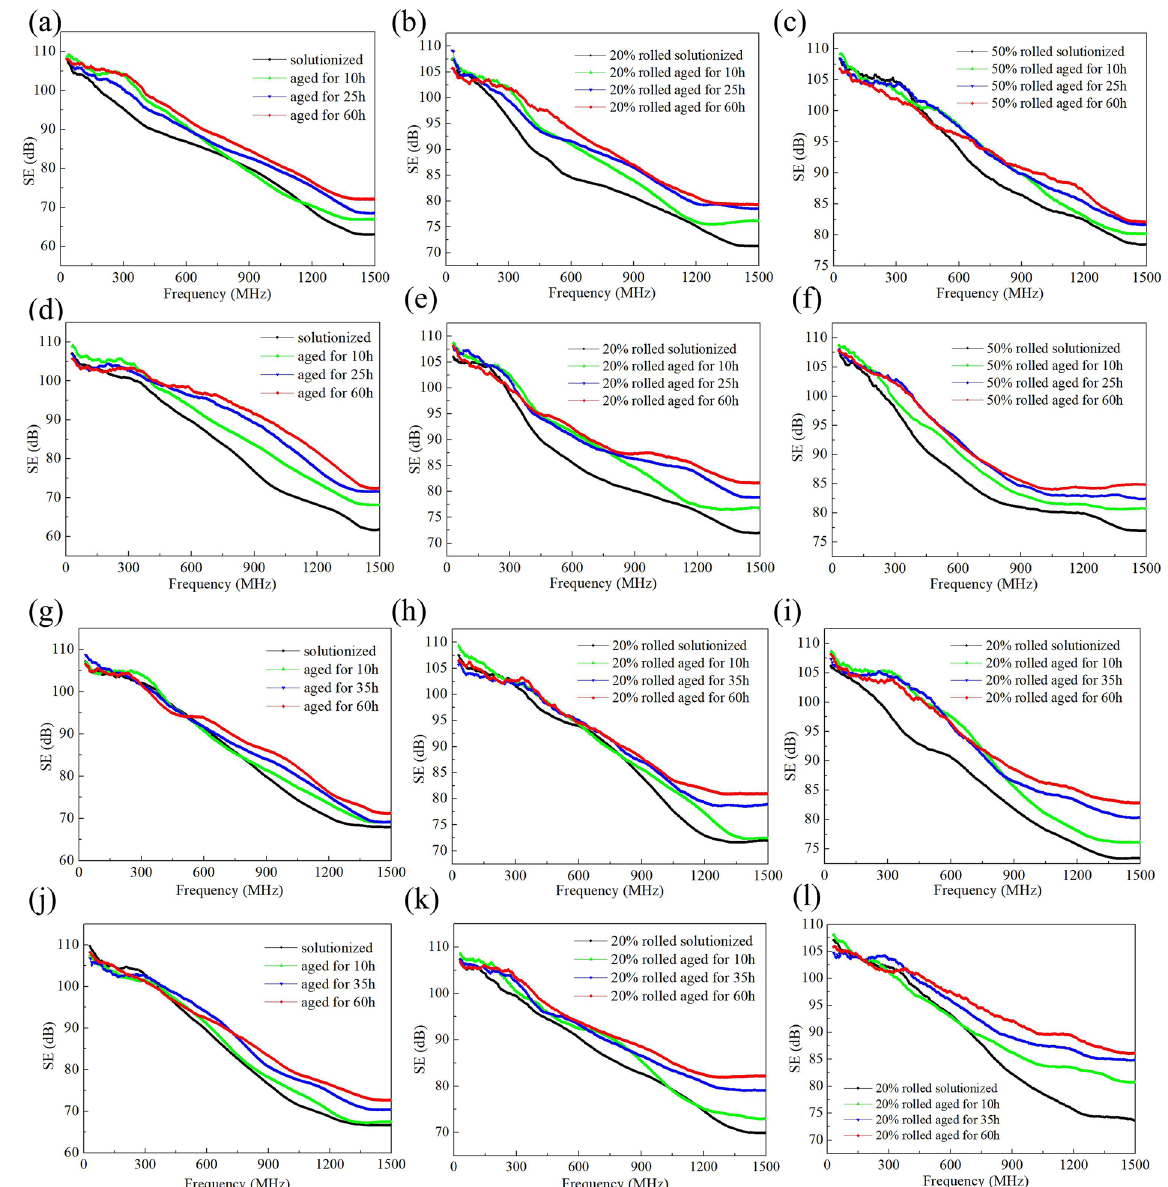
Figure 12. Variation in electromagnetic shielding effectiveness with frequency: ( a – c ) Mg-3Zn, ( d – f ) Mg-5Zn, ( g – i ) Mg-3Sn, and ( j – l )